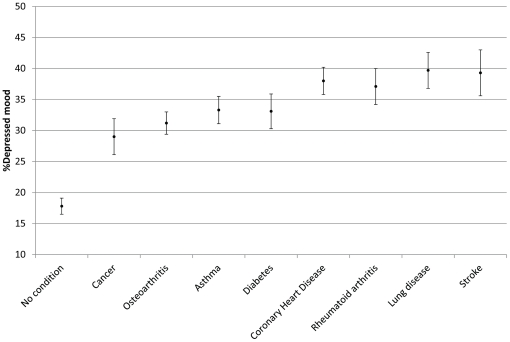
Percentage depressed mood adjusted for age, gender, and wealth.Percentage of depressed mood (95% CI), adjusted for age, gender and wealth, for respondents with no condition and for all eight chronic conditions. Higher scores indicate greater depressed mood.